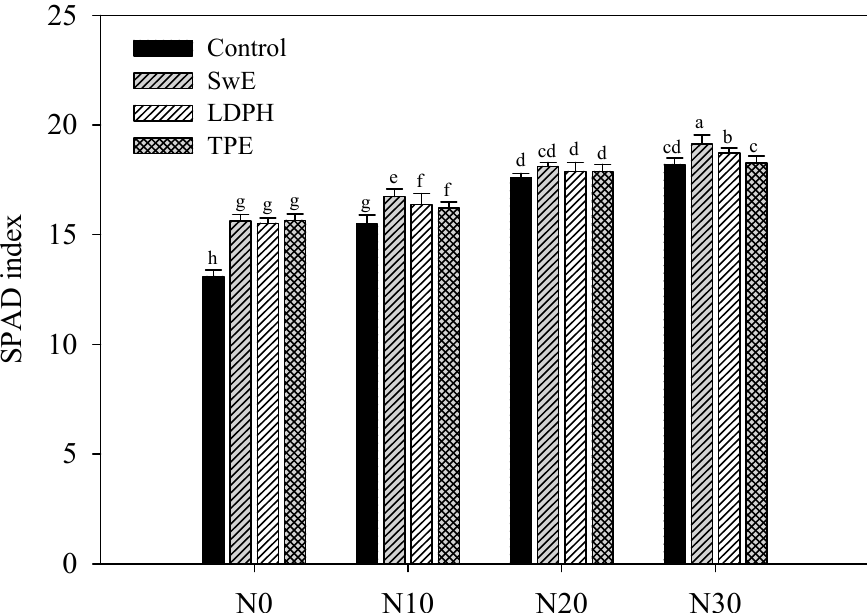
Figure 4. E ff ects of nitrogen (N) fertilization levels (0, 10, 20 and 30 kg N · ha − 1 ; N0, N10, N20 and N30, respectively) and biostimulant applications (untreated control, SwE: Extract of seaweed Ecklonia maxima , LDPH: Legume-derived protein hydrolysate and TPE: Tropical plant extract) on the SPAD index of baby lettuce plants. Di ff erent letters indicate significant di ff erences according to the Duncan’s test (significance level 0.05).